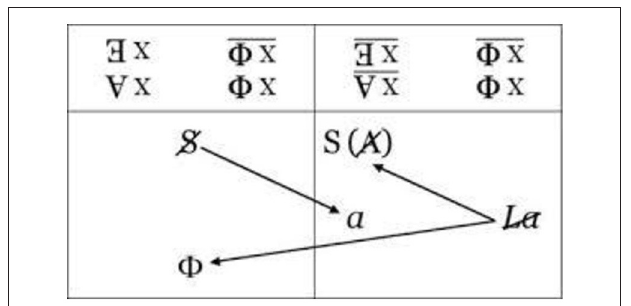
FIGURE 3 | The diagram of sexual difference, J. Lacan seminar